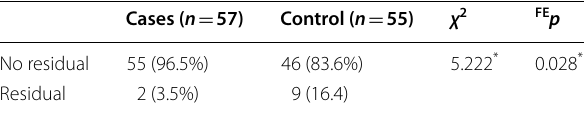
Table 6 Comparison between the two studied groups according to residual